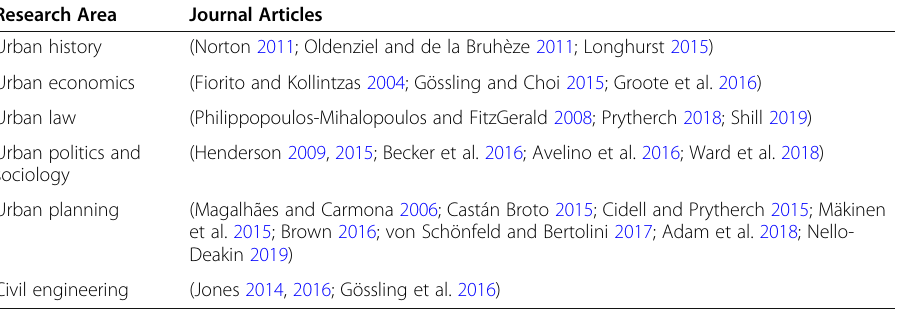
Table 3 Sources for thematic review of space concepts in non-transitions literature